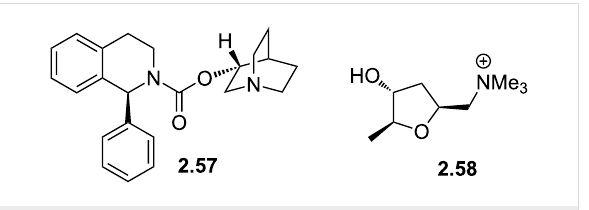
Figure 6: Structures of solifenacin ( 2.57 ) and muscarine ( 2.58